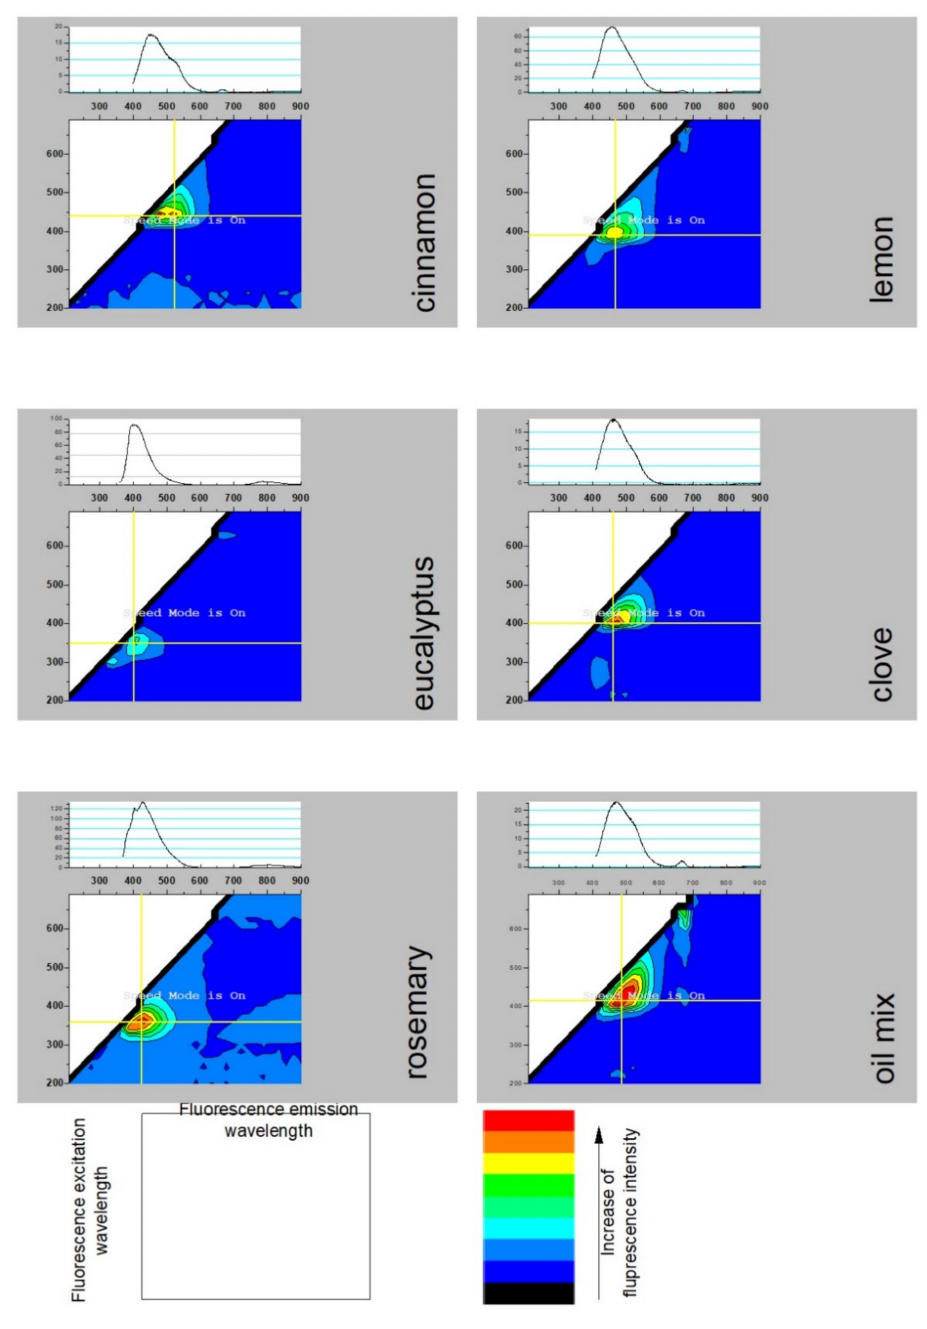
Figure 3. Fluorescence patterns and representative fluorescence emission spectra of the examined